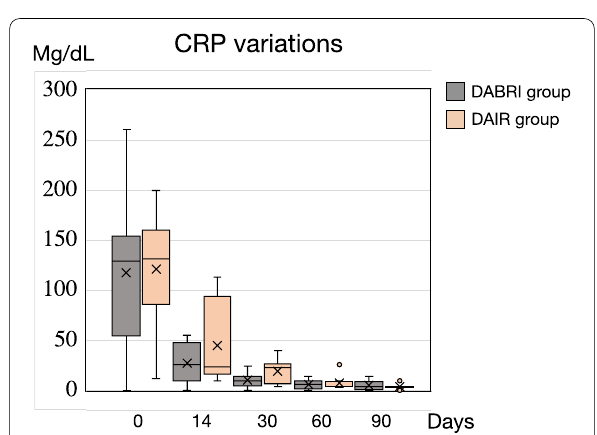
Fig. 2 C-reactive protein (CRP) variations over time in DAIR and DABRI